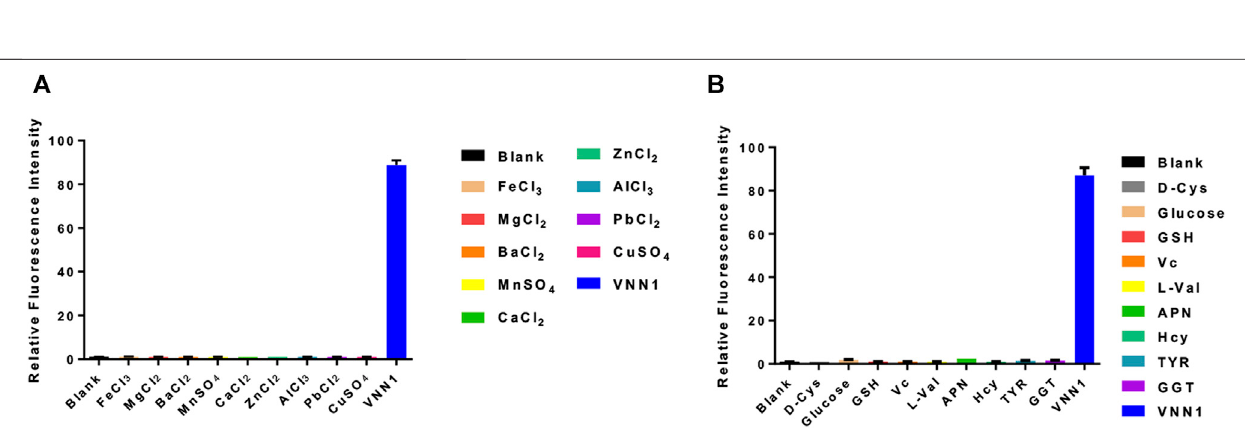
FIGURE 3 | Probe in vitro selectivity experiment. (A) Relative fl uorescence intensity of probe PA-AFC and various inorganic salts (1 mM), VNN1 enzyme concentration is 15 ng/ml; (B) Relative fl uorescence intensity of probe PA-AFC and the following substance: Reduced glutathione (1 mM), D-cysteine (1 mM), glucose